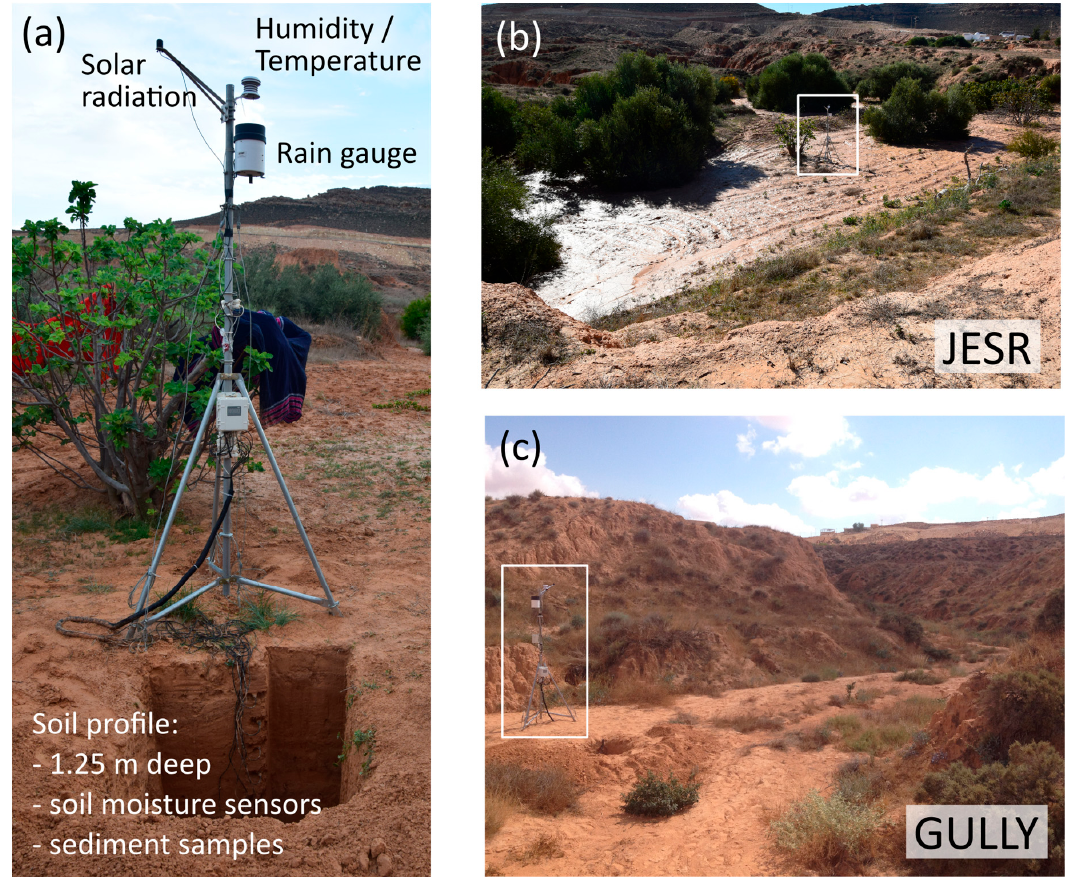
Figure 4. ( a ) Components of the measurement system; location in ( b ) the Jesr and ( c ) the gully. Photos: Martin Calianno. Table 2. Equipment installed at the measurement stations, parameters measured, units and time steps.